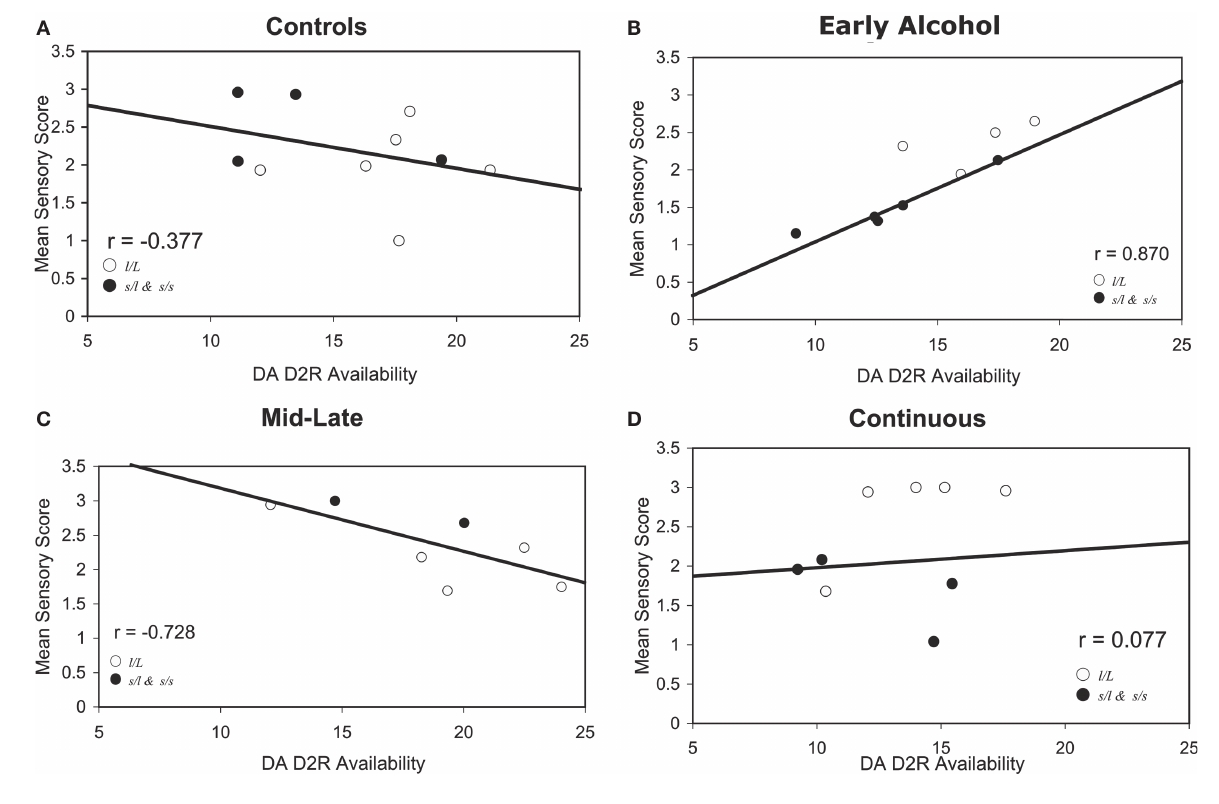
FIGURE 2 | (A–D) Correlations of DA-ergic parameters measured with PET and mean sensory scores in (A) control, (B) early gestation, (C) middle-to-late gestation, and (D) continuous prenatal alcohol-exposed monkeys. This fi gure illustrates a signifi cant difference in correlations across groups ( p < 0.05):